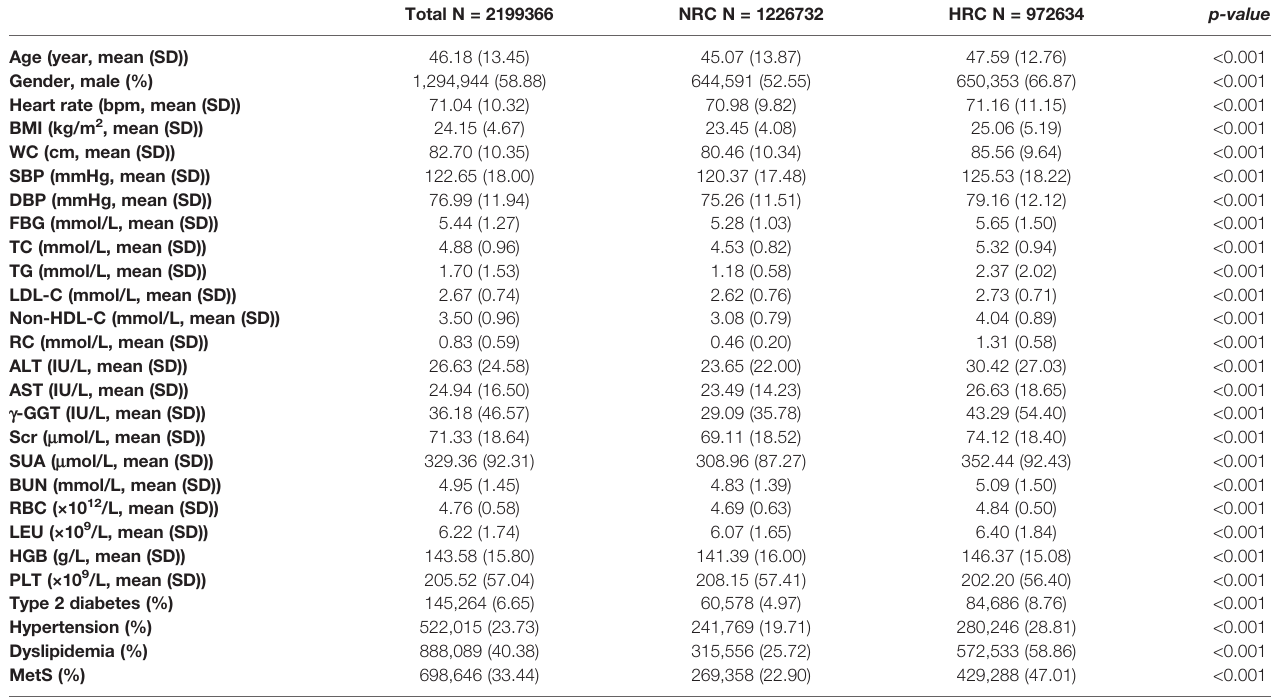
TABLE 1 | Clinical characteristics in total and strati fi ed by RC levels in a cross-sectional analysis.